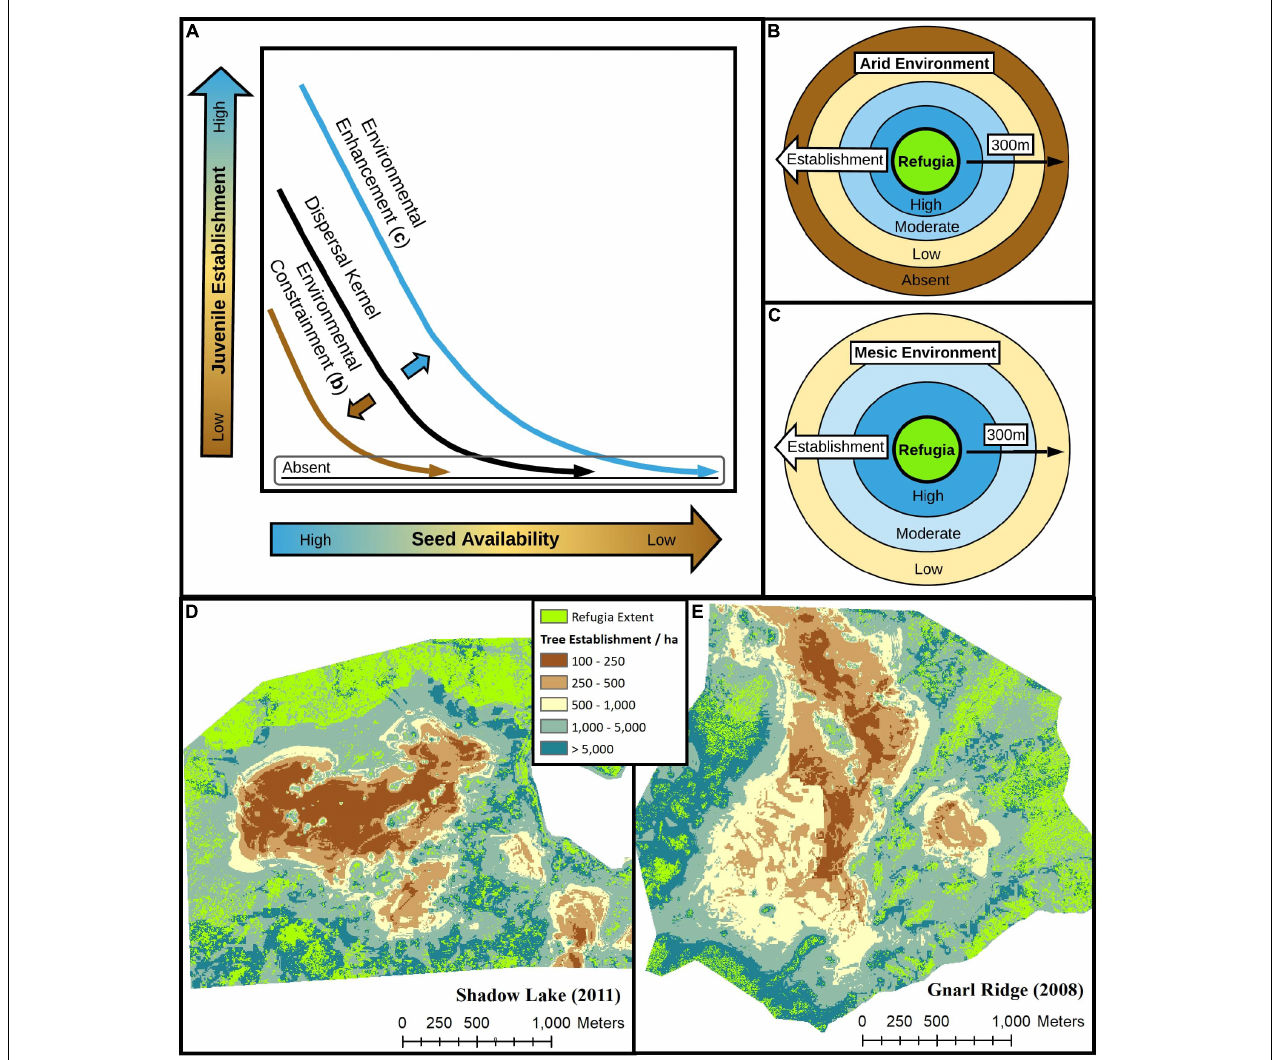
FIGURE 6 | For wind-dispersed tree species along a gradient of seed availability, post-fire juvenile establishment responses are determined by interactions between biotic and abiotic environmental controls and the spatial and structural (e.g., age, size, height) configuration of seed sources, including fire refugia, at the landscape scale. Across gradients of water deficit to vegetation explained by macro-scale climatic and micro-scale topographic and biotic features, arid environments (B) constrain while mesic environments (C) enhance dispersal kernels (A) and thus juvenile establishment responses at increasing distances from fire refugia for most species, when refugia extent and structure remain constant. (D,E) Variability in modeled juvenile density patterns over space of all species combined (D,E) illustrate the important influence of and interactions between seed availability (refugia D2WD), mean climate conditions (climate water deficit), and topography (slope and heat load index) on post-fire tree establishment responses in panel (D) the warmer, drier and topographically flatter 2011 Shadow Lake Fire and (E) the cooler, wetter, and topographically steeper 2008 Gnarl Ridge